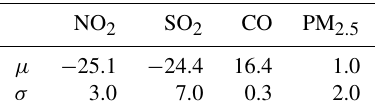
Table A1. Normalization constants for lognormally distributed chemical species.